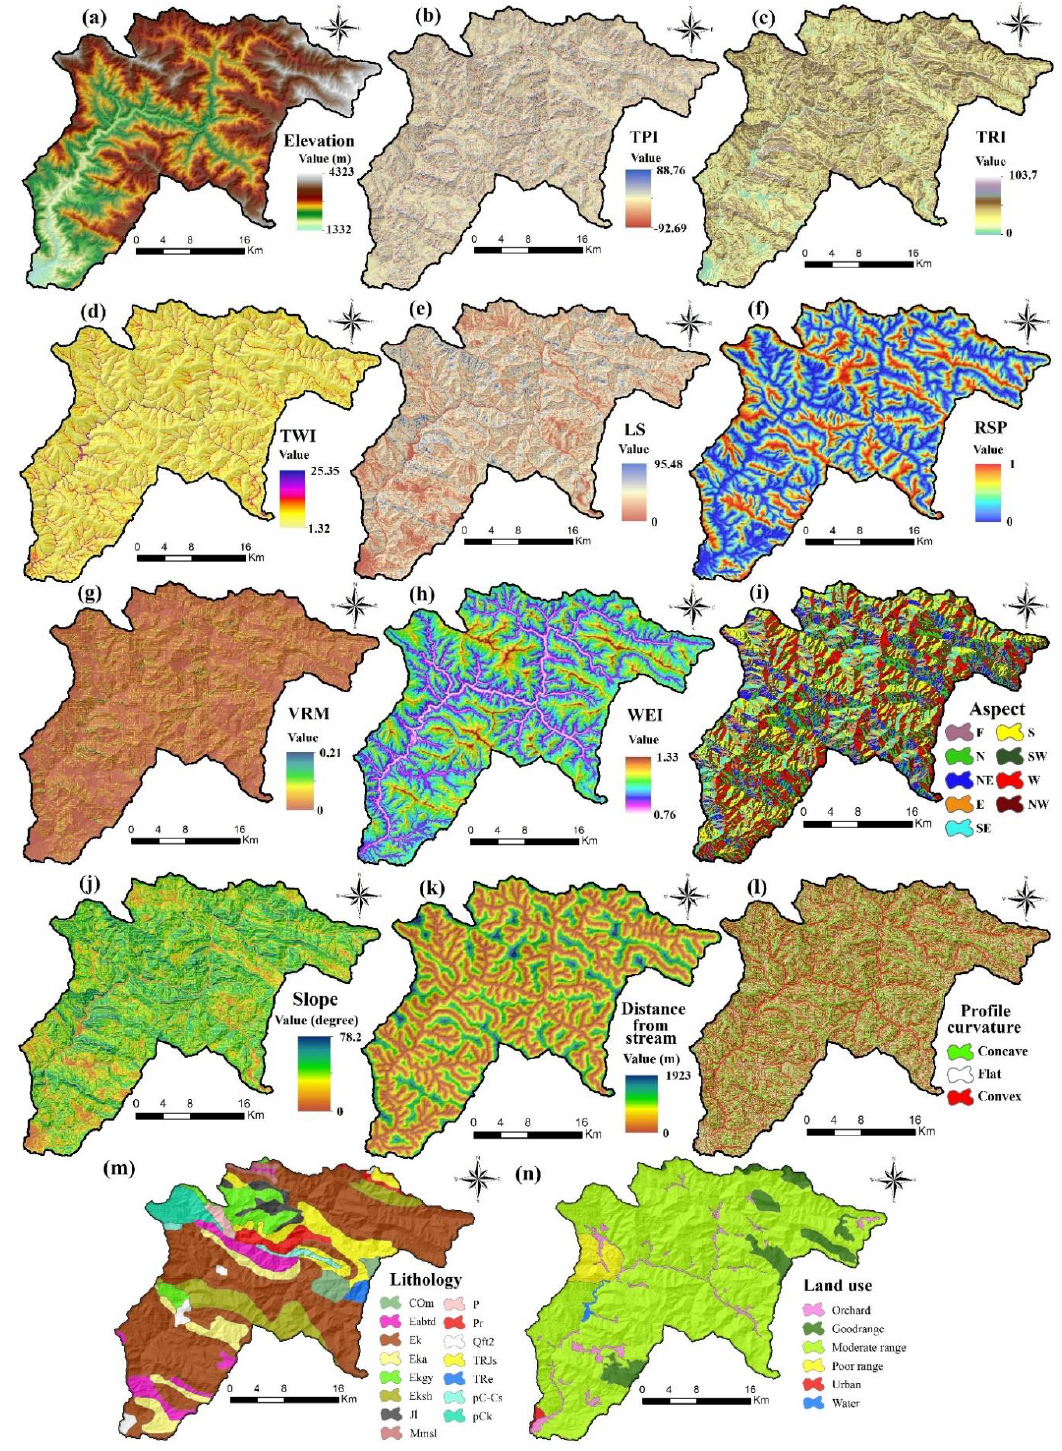
Figure 3. Predictive factors: ( a ) Elevation, ( b ) TPI, ( c ) TRI, ( d ) TWI, ( e ) LS, ( f ) RSP, ( g ) VRM, ( h ) WEI, ( i ) aspect, ( j ) slope, ( k ) distance from stream, ( l ) profile curvature, ( m ) lithology, and ( n ) land use.